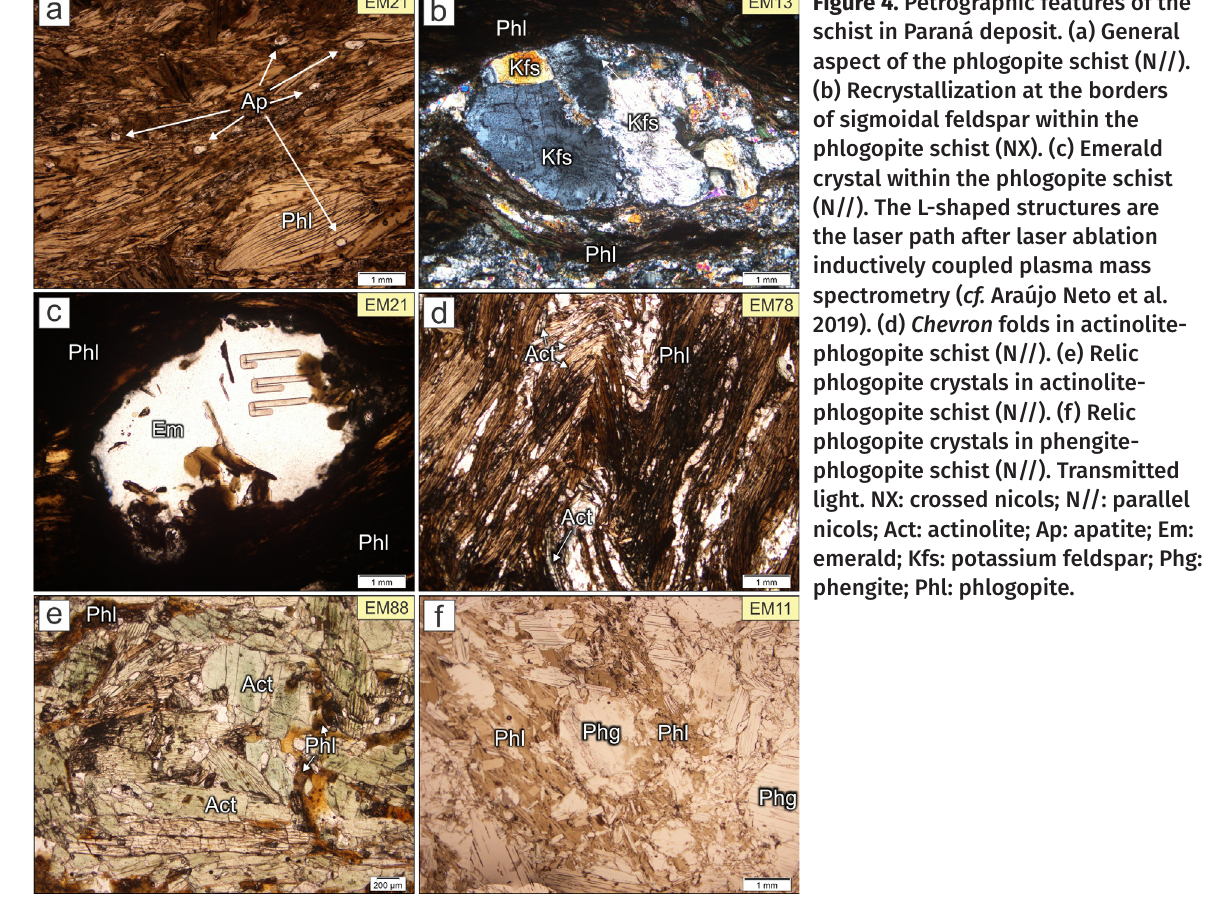
Figure 4. Petrographic features of the schist in Paraná deposit. (a) General aspect of the phlogopite schist (N//). (b) Recrystallization at the borders of sigmoidal feldspar within the phlogopite schist (NX). (c) Emerald crystal within the phlogopite schist (N//). The L-shaped structures are the laser path after laser ablation inductively coupled plasma mass spectrometry ( cf. Araújo Neto et al. 2019). (d) Chevron folds in actinolite- phlogopite schist (N//). (e) Relic phlogopite crystals in actinolite- phlogopite schist (N//). (f) Relic phlogopite crystals in phengite- phlogopite schist (N//).